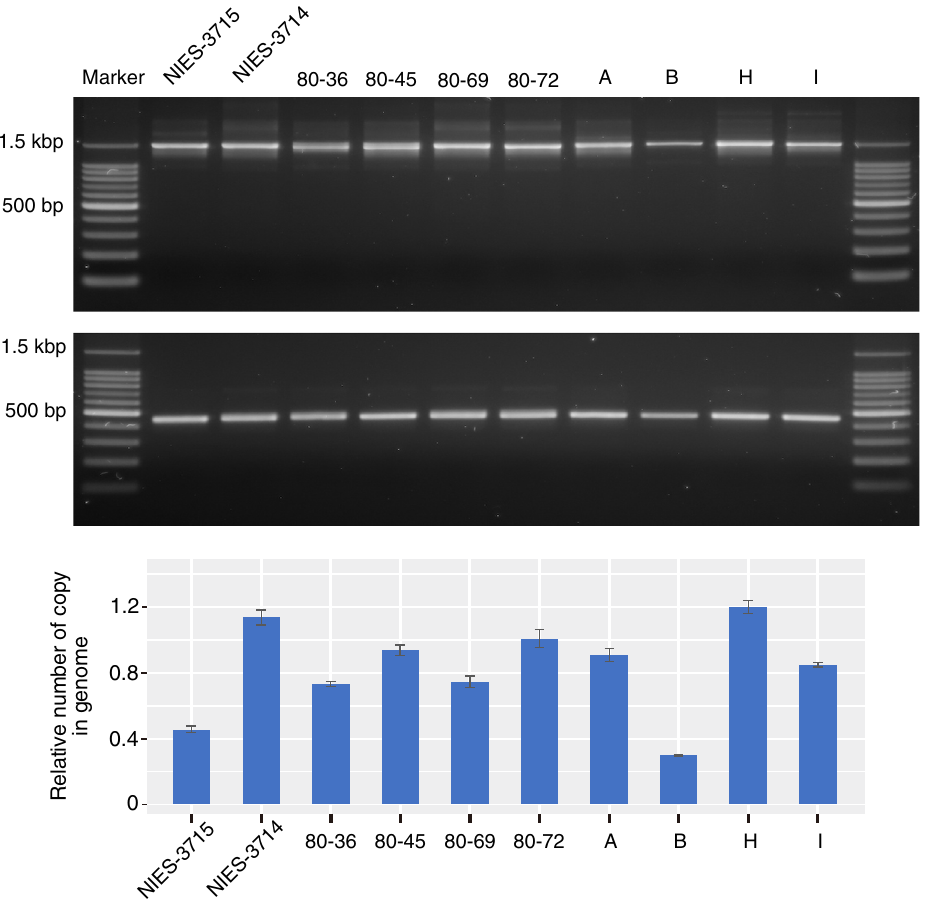
Figure 2. PCR amplification and copy number of the EVLF from the genomes of C. tenuissimus strains, isolated from the seawater sampling sites shown in Supplementary Fig. 7. The upper and lower PCR bands were amplified using ctEVLF-out-v1 and ctEVLF-in-v1 primer sets, respectively. The bar plot indicated relative numbers of EVLF copies in the genomes of each strain. The EVLF copies were relativised by the EVLF copy of NIES-3715 used ctEVLF-q-v1 primer and probe set. The EVLF copy numbers of all strains were measured using ctEVLF-q-v2 primer and probe